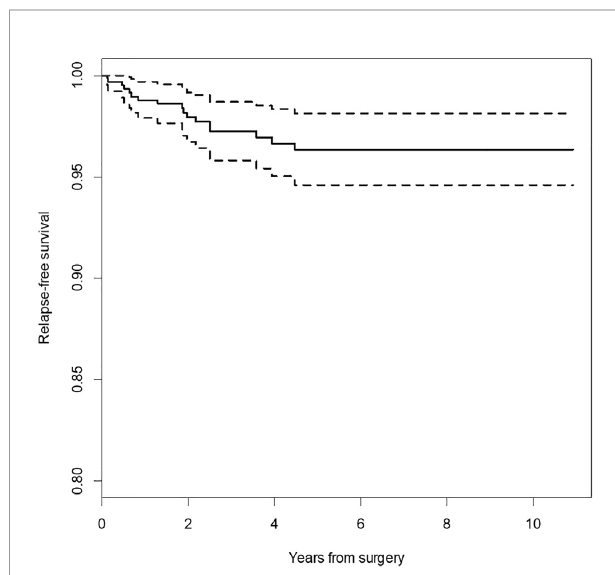
FIGURE 1 | Kaplan-Meier survival curve for relapse-free survival (RFS). Dotted lines indicate 95% con fi dence interval for survival curve.